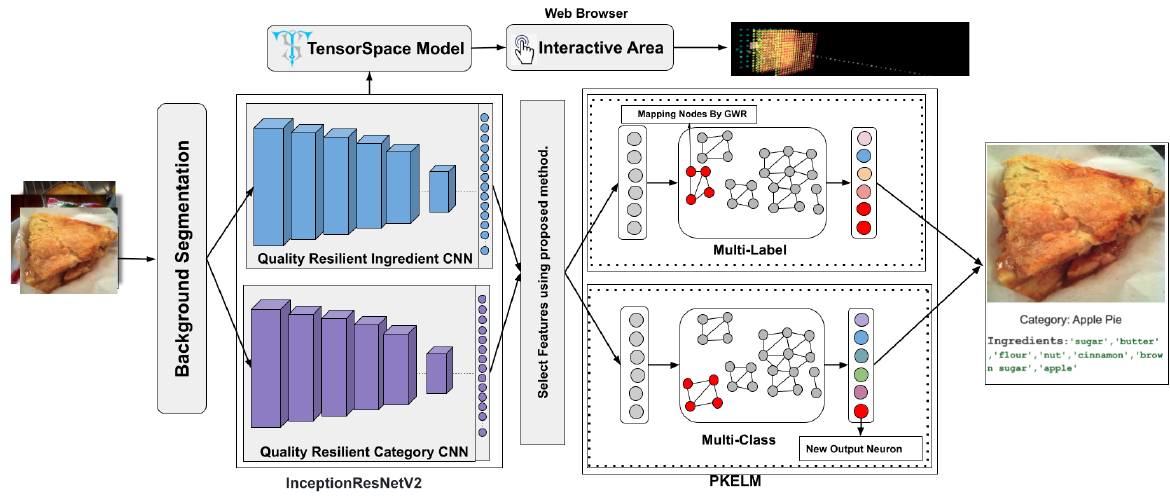
Figure 1. Flow chart of the proposed framework. The red dot presents new neurons during progressive